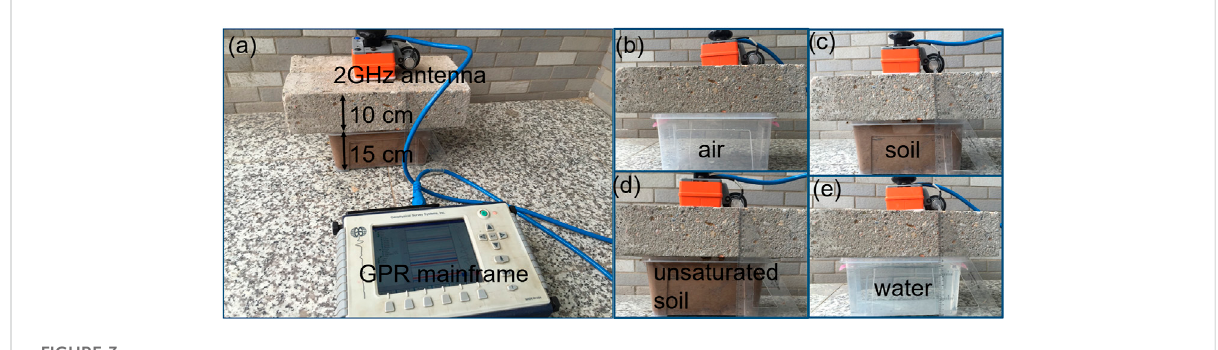
FIGURE 3 Physicsexperimentalequipmentandmodels (A) GPRmainframeandphysicalmodel; (B) concrete-air interface; (C) concrete-soilinterface; (D) concrete-unsaturated soils; and (E)